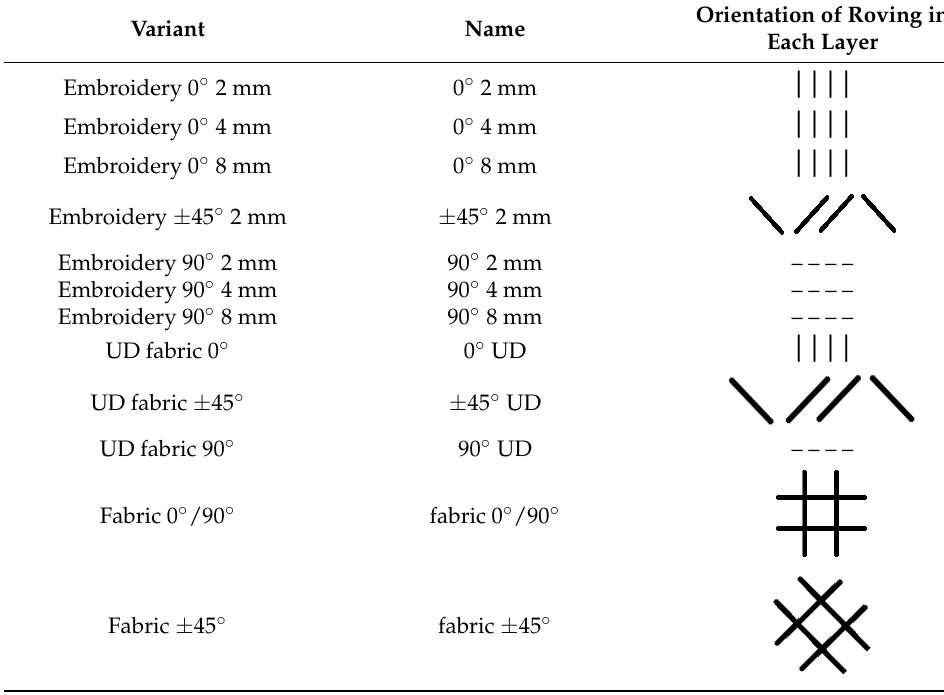
Table 1. Types of produced Table 1. Types of produced reinforcements. Table 1. Types of produced reinforcements. Table 1. Types of produced reinforcements. Table 1. Types of produced reinforcements. Table 1. Types of produced reinforcements. Variant